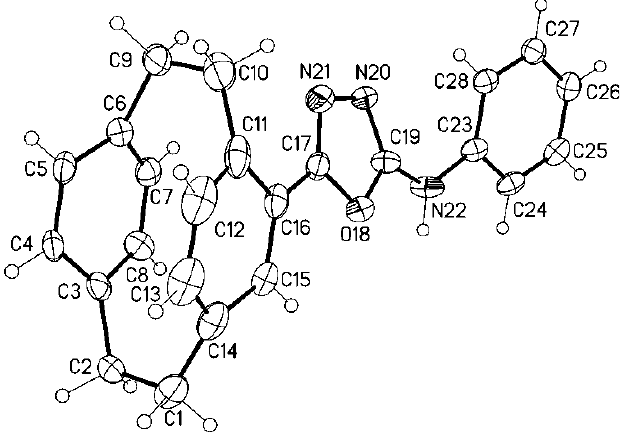
Scheme 6. Internal cyclization of N -substituted 11a – f into 5-(1,4(1,4)-dibenzenacyclohexaphane- 1 2 -yl)- N -substituted-1,3,4-oxadiazol-2-amines 13a – f .